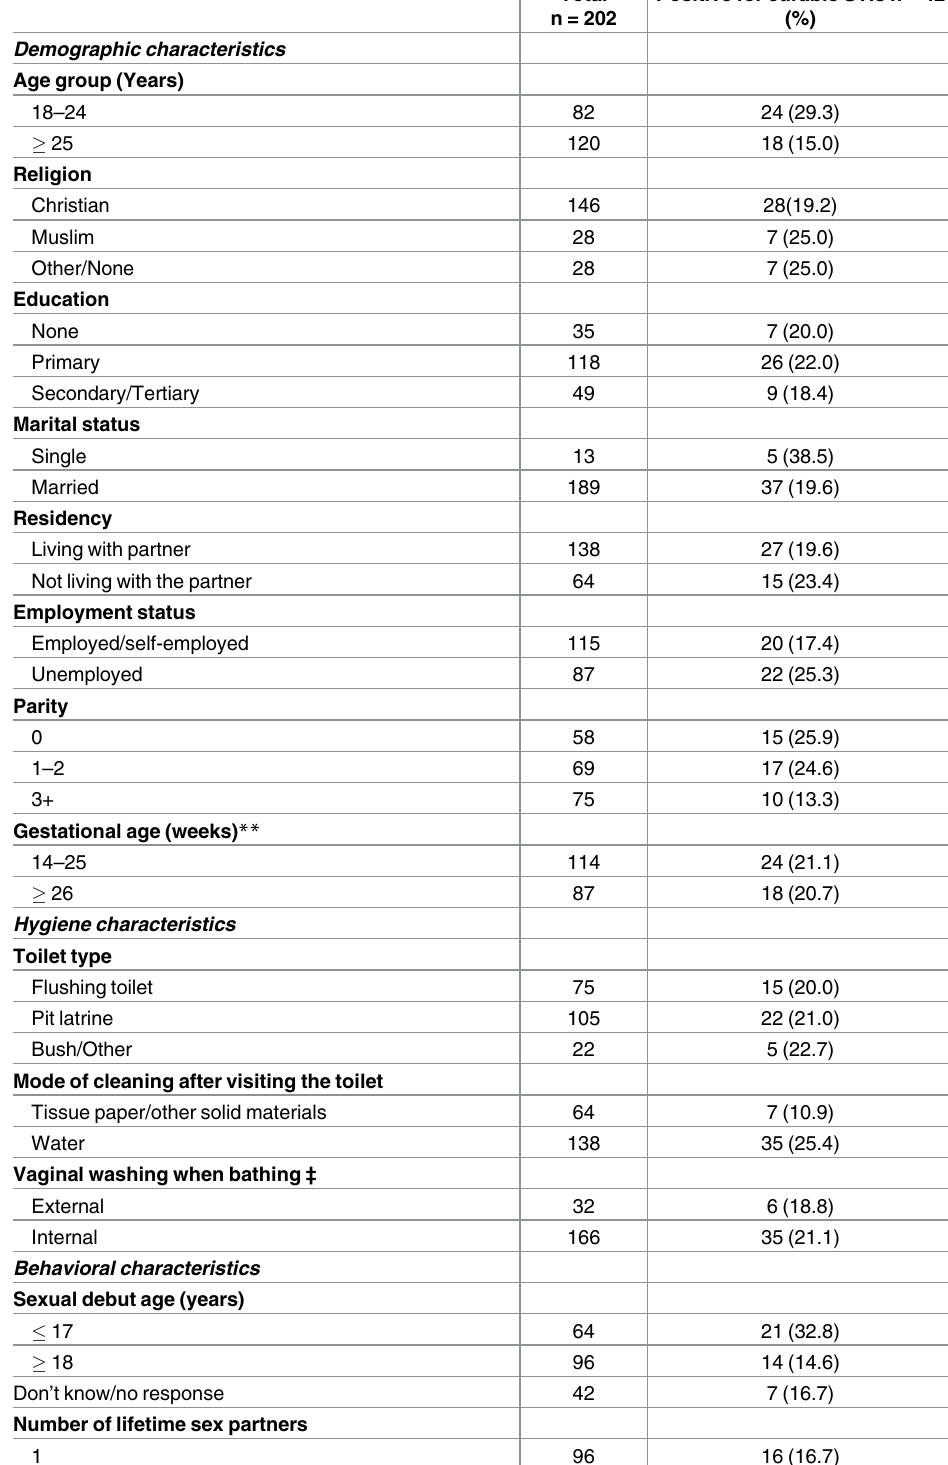
Table 1. Socio-demographic, hygienic, and behavioral characteristics of 202 women attending ante- natal care and tested for sexually transmitted infections and bacterial vaginosis in Kilifi County Hos- pital, Kenya, July-September